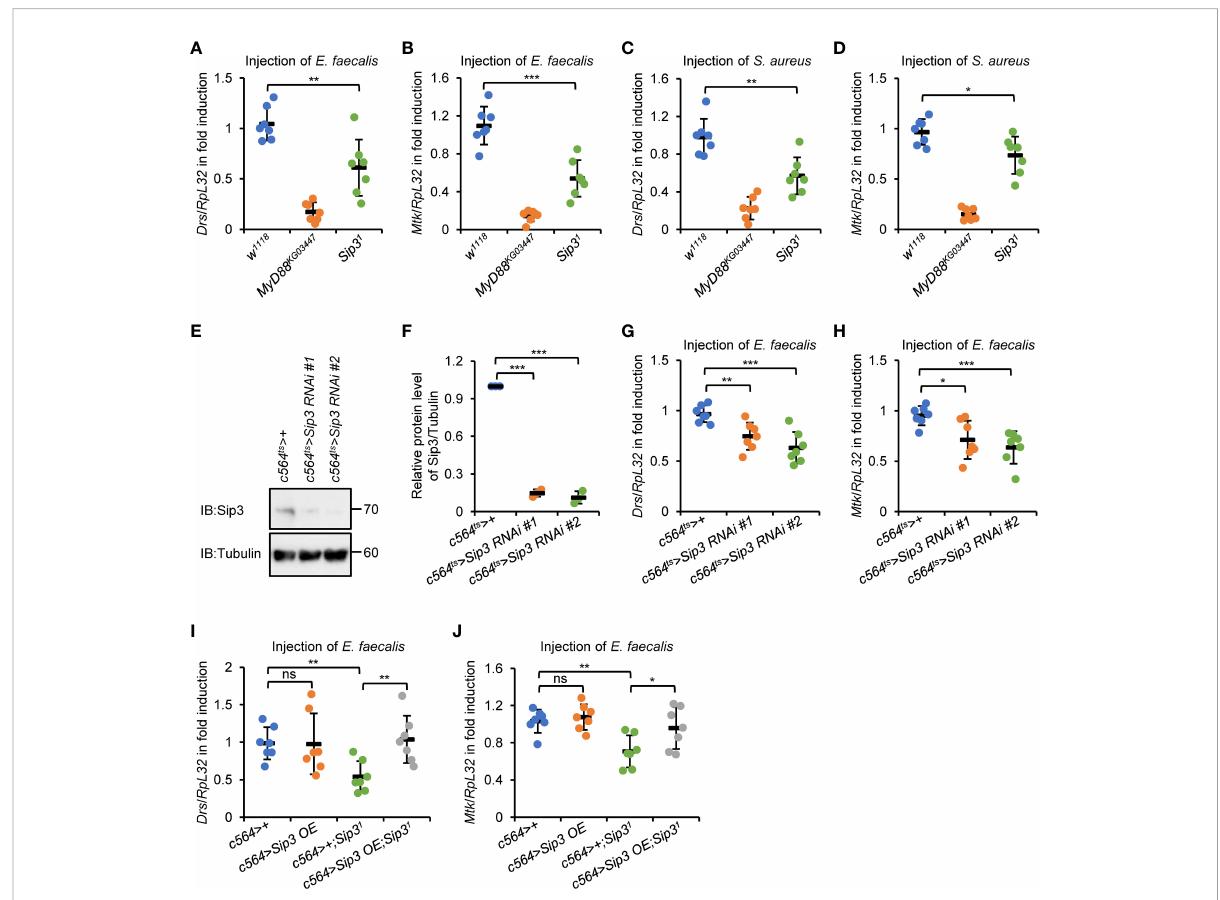
FIGURE 1 E3 ligase Sip3 positively regulates Toll signaling in Drosophila . (A – D) Wild-type ( w 1118 ), MyD88 KG03447 , and Sip3 1 mutant fl ies were injected with E. faecalis (A, B) or S. aureus (C, D) for 12 h, followed by RT-qPCR assays to monitor the expression levels of Drs (A, C) or Mtk (B, D) . Each dot represents one independent replicate (10 fl ies for each replicate). (E, F) Fat bodies were dissected from fl ies (10 fl ies for each sample) including c564 ts >+ , c564 ts >Sip3 RNAi #1 , and c564 ts >Sip3 RNAi #2 , followed by Western blot assays (E) . Tubulin was used as loading control. Densitometry analysis to quantify the protein level of samples in (E) is shown in (F) . (G, H) Flies including c564 ts >+ , c564 ts >Sip3 RNAi #1 , and c564 ts >Sip3 RNAi #2 were infected with E. faecalis. 12 h later, fl ies were harvested for RT-qPCR assays to detect the transcript levels of Drs (G) or Mtk (H) . Each dot represents one independent replicate (10 fl ies for each replicate). (I) and (J) Flies including c564>+ , c564>Sip3 OE , c564>+; Sip3 1 , and c564>Sip3OE;Sip3 1 were infected with E. faecalis , followed by RT-qPCR assays as in (G) and (H) . Each dot represents one independent replicate (10 fl ies for each replicate). In (A – D) and (F, J) , data are shown as mean ± standard errors. * p < 0.05; ** p < 0.01; *** p < 0.001; ns, not signi fi